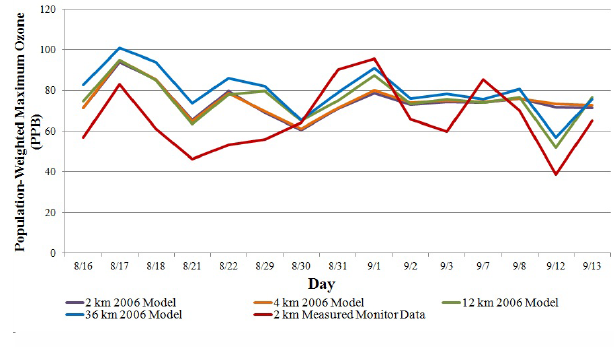
Fig. 3. Population-weighted maximum ozone concentration for each resolution from the 2006 episode compared to the population- weighted maximum ozone concentration calculated from the mea- sured values at the monitors using the 2km resolution. Modeled results are shown for 36km (blue), 12km (green), 4km (orange) and 2km (purple) and measured results are shown for 2km